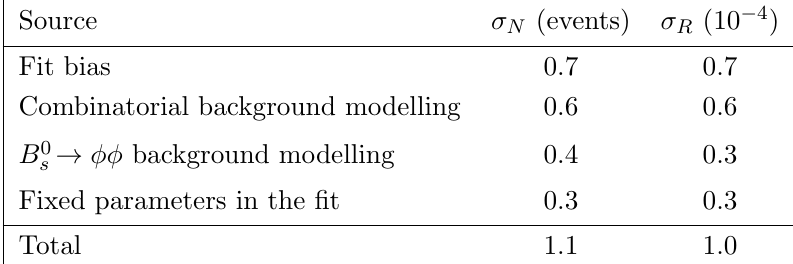
Table 3 . Systematic uncertainties (cid:27) N and (cid:27) R on the (cid:12)tted yield N ( B 0 ratio R = N ( B 0 (cid:17) 0 (cid:30) ) =N ( B + (cid:17) 0 K + ), respectively. The last line gives the quadratic sum of the s ! ! individual